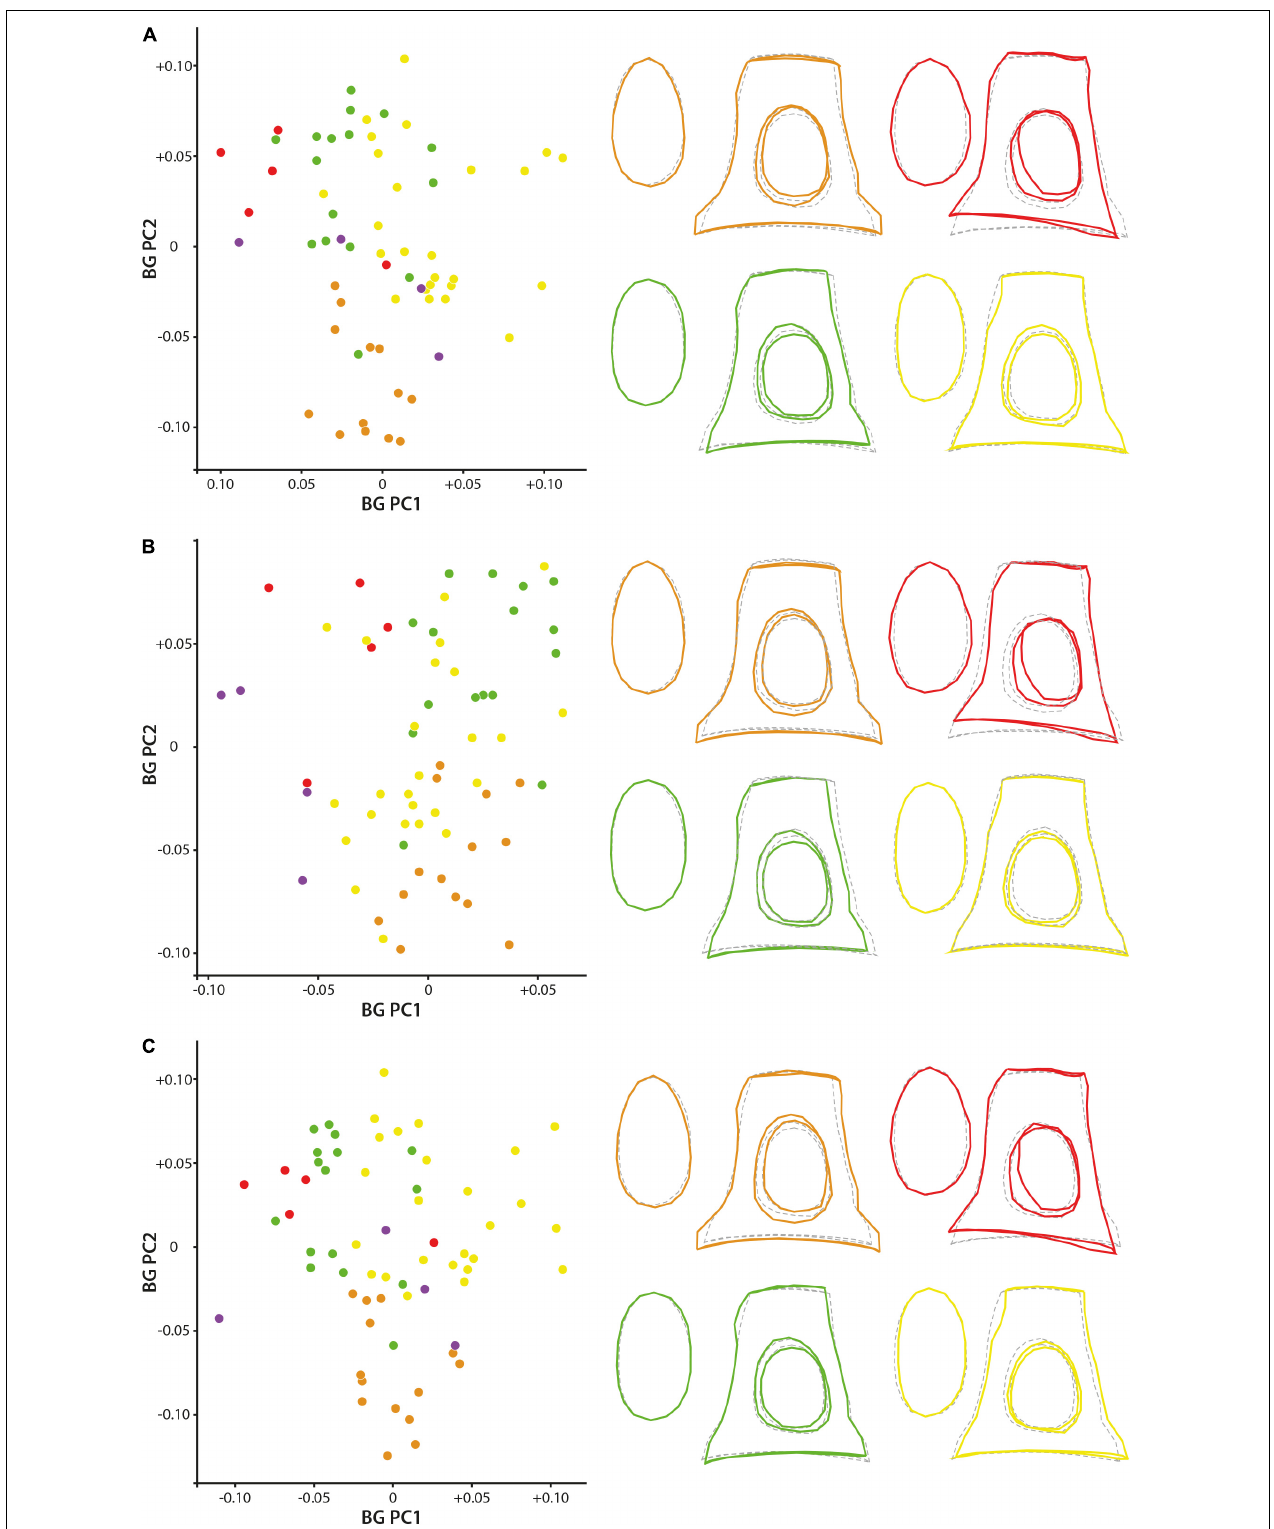
FIGURE 5 | Geometric morphometric bg-PCA results. (A) stapes based on the original 3D landmarks coordinates (dataset 1; PC1 = 45.5%, PC2 = 23.7%), (B) dataset without allometrical signal not pooled by family (dataset 2; PC1 = 45.4%, PC2 = 23.1%), and (C) dataset without allometrical signal pooled by family (dataset 3; PC1 = 47.2%, PC2 = 23.9%). The mean shape of the Antilocapridae is red, of the Bovidae is yellow, of the Cervidae is green, and of the Tragulidae is orange.